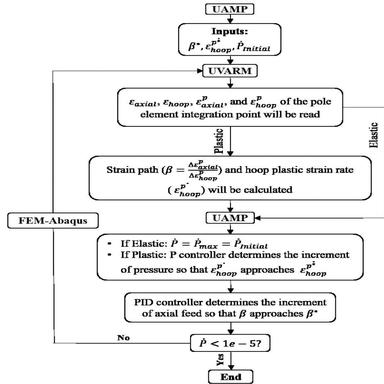
PID controller algorithm for boundary condition generation based on strain path control in free tube bulging process.